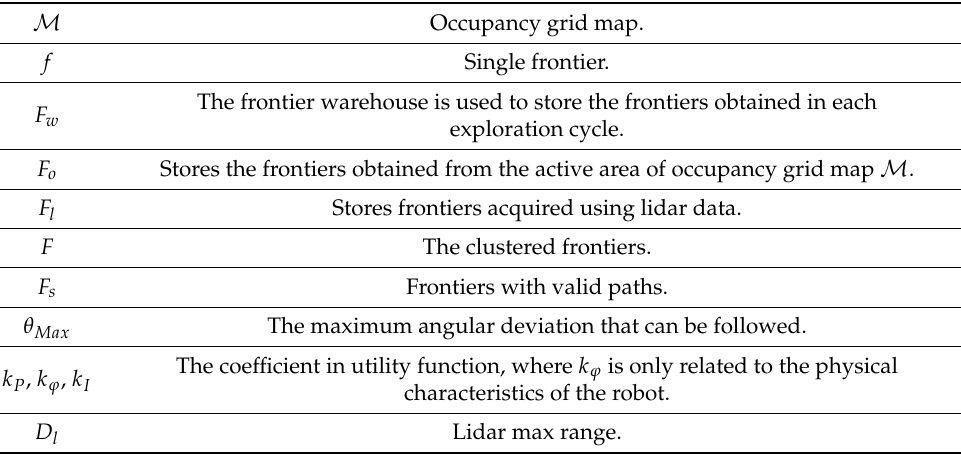
Table 2. Common symbols and meanings used in this